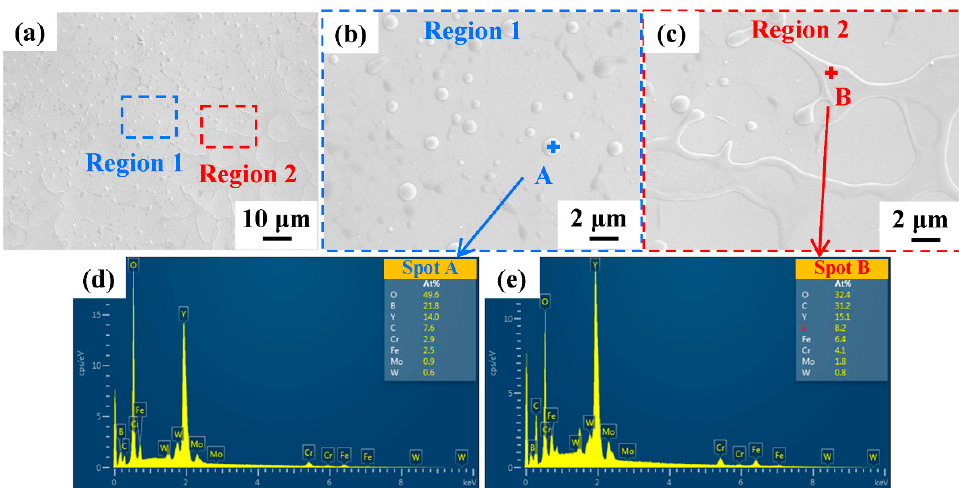
Figure 5. ( a ) SEM images of the sample S1 coating surface after NPLP; ( b , c ) surface structures after magnification; ( d , e ) EDS analysis results of regions A and B, respectively. magnification; ( d , e ) EDS analysis results of regions A and B,